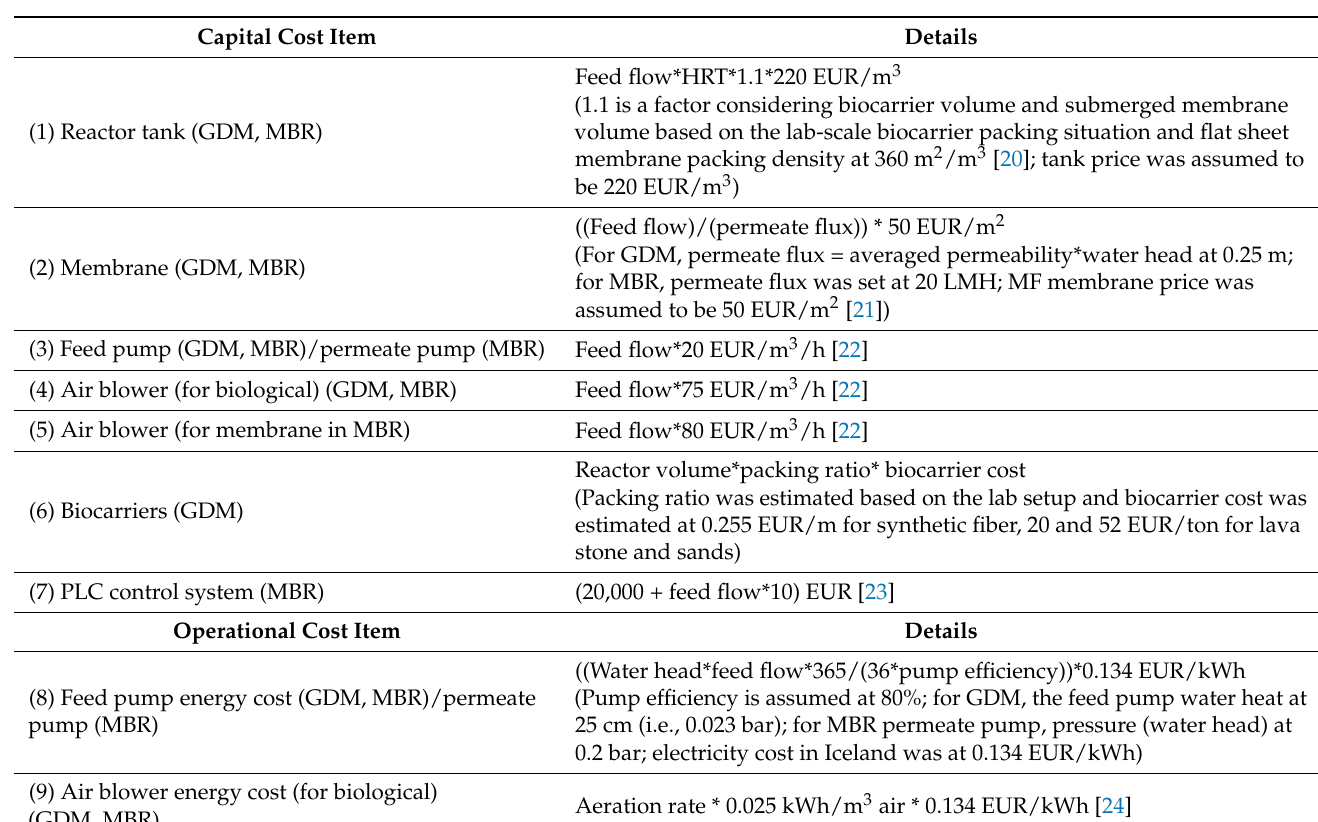
Table 2. The details of capital and operational cost